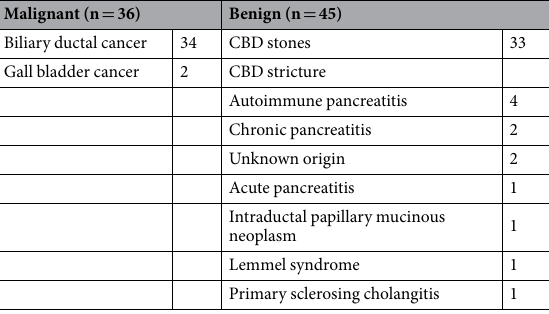
Table 5. Biliary diseases and the causes of biliary stricture in the patients. CBD , common bile